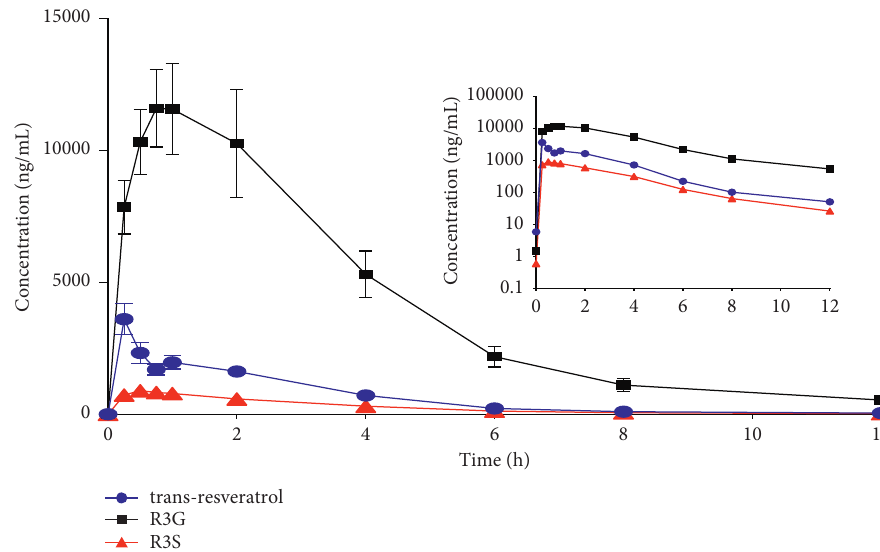
Figure 4: Mean blood concentration-time curves of trans-resveratrol, trans-resveratrol-3-o- β -glucuronide (R3G), and trans-resveratrol-3- sulfate salt (R3S) in blood from six mice after the intragastric administration of 150mg/kg